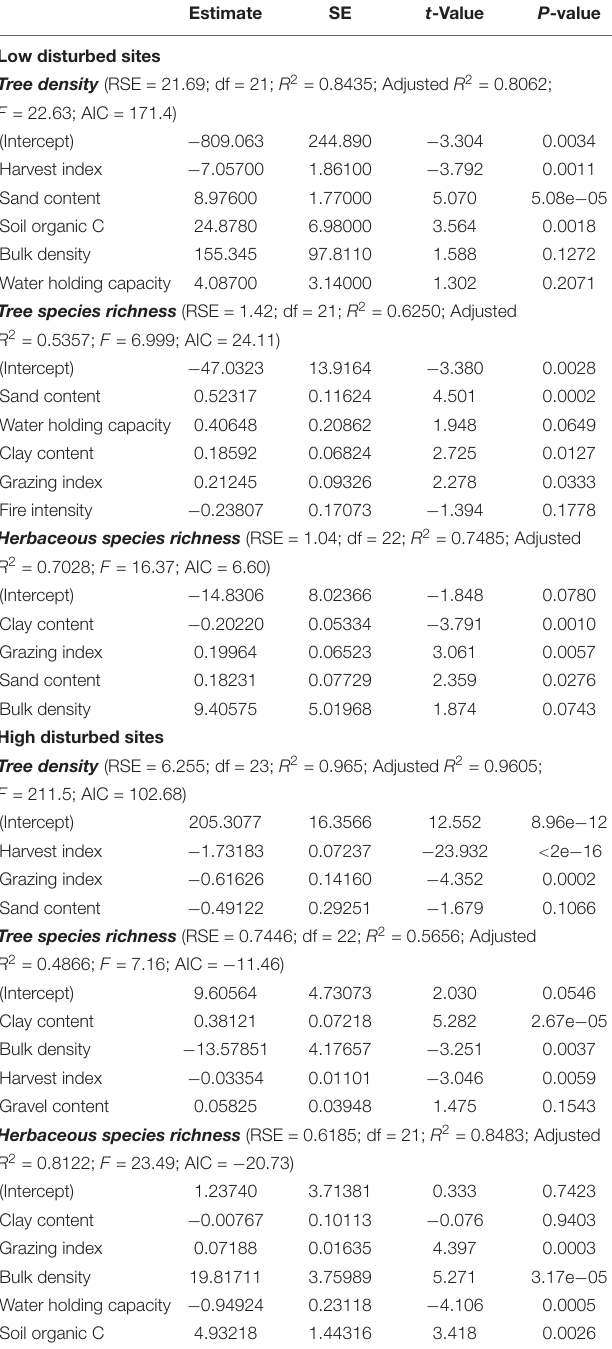
TABLE 2 | Summary of step-wise regression coefficients.